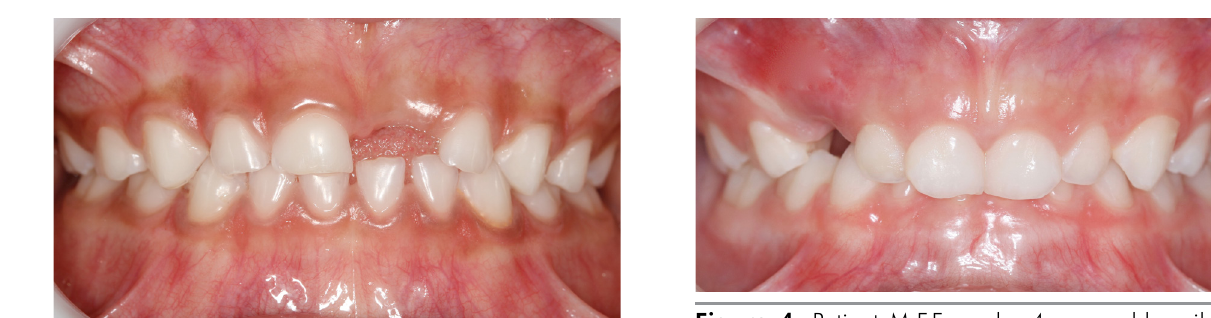
Figure 4. Patient M.F.F., male, 4 years old, unilateral premature loss of primary canine (53). Intraoral frontal photograph 15 days after the loss. (Image by Fernanda Vieira, Master’s student - CVMT/FO-UFRJ ® ).